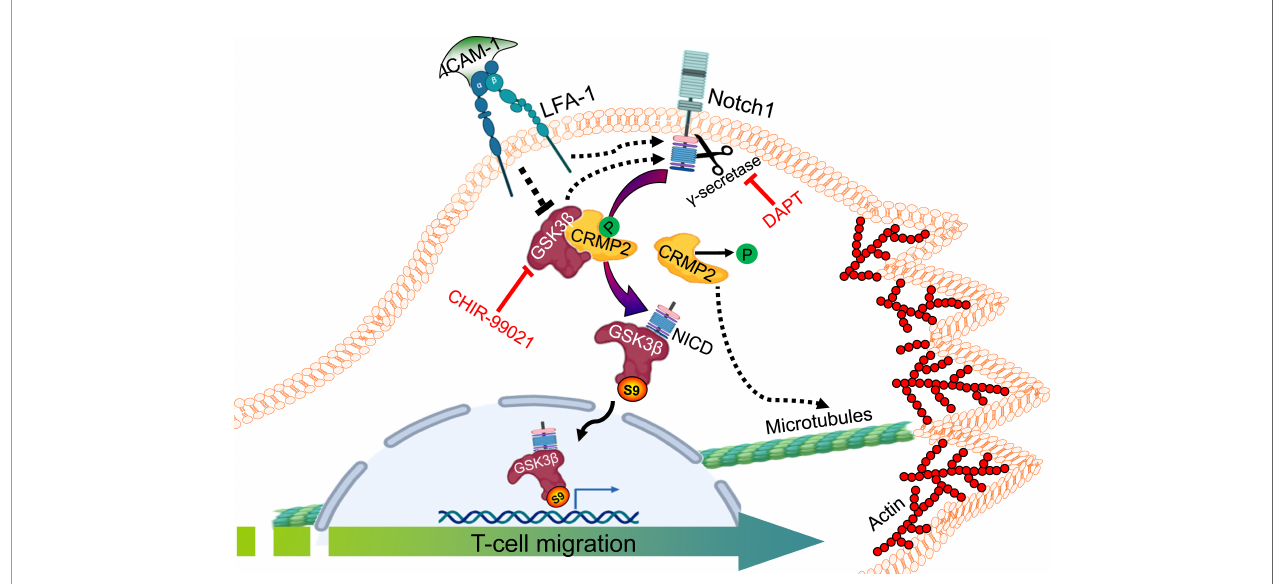
FIGURE 6 | An illustration of GSK3 b -Notch1 and GSK3 b -CRMP2 interactions in T-cell motility. LFA-1 stimulation-mediated signals in motile T-cells inactivate GSK3 b by inducing its Ser9 phosphorylation. pGSK3 b -S9 interacts with cleaved NICD and translocates to the nucleus. CRMP2 released from bound GSK3 b further coordinates T-cell motility. The image created with